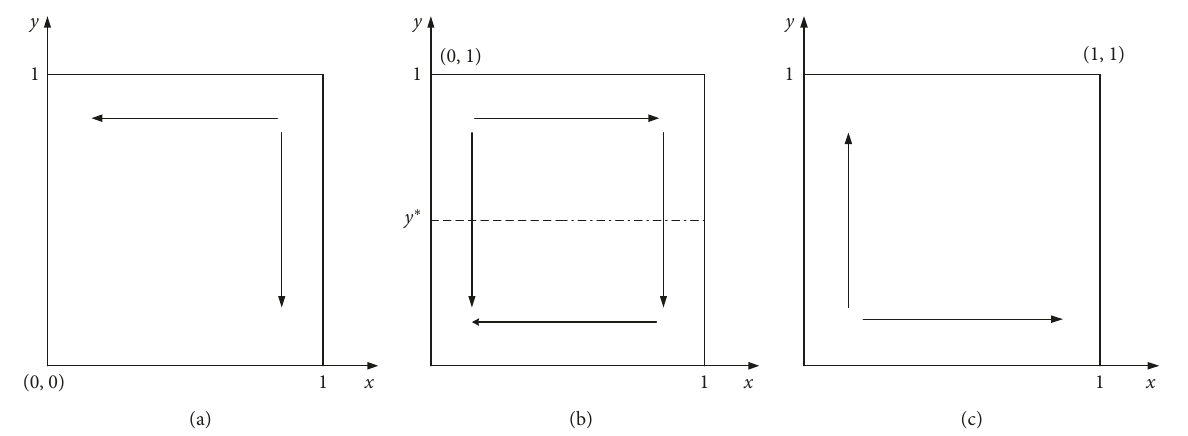
Figure 5: Dynamic evaluation diagram of strategies between the government and external investors. (a) v v > 8